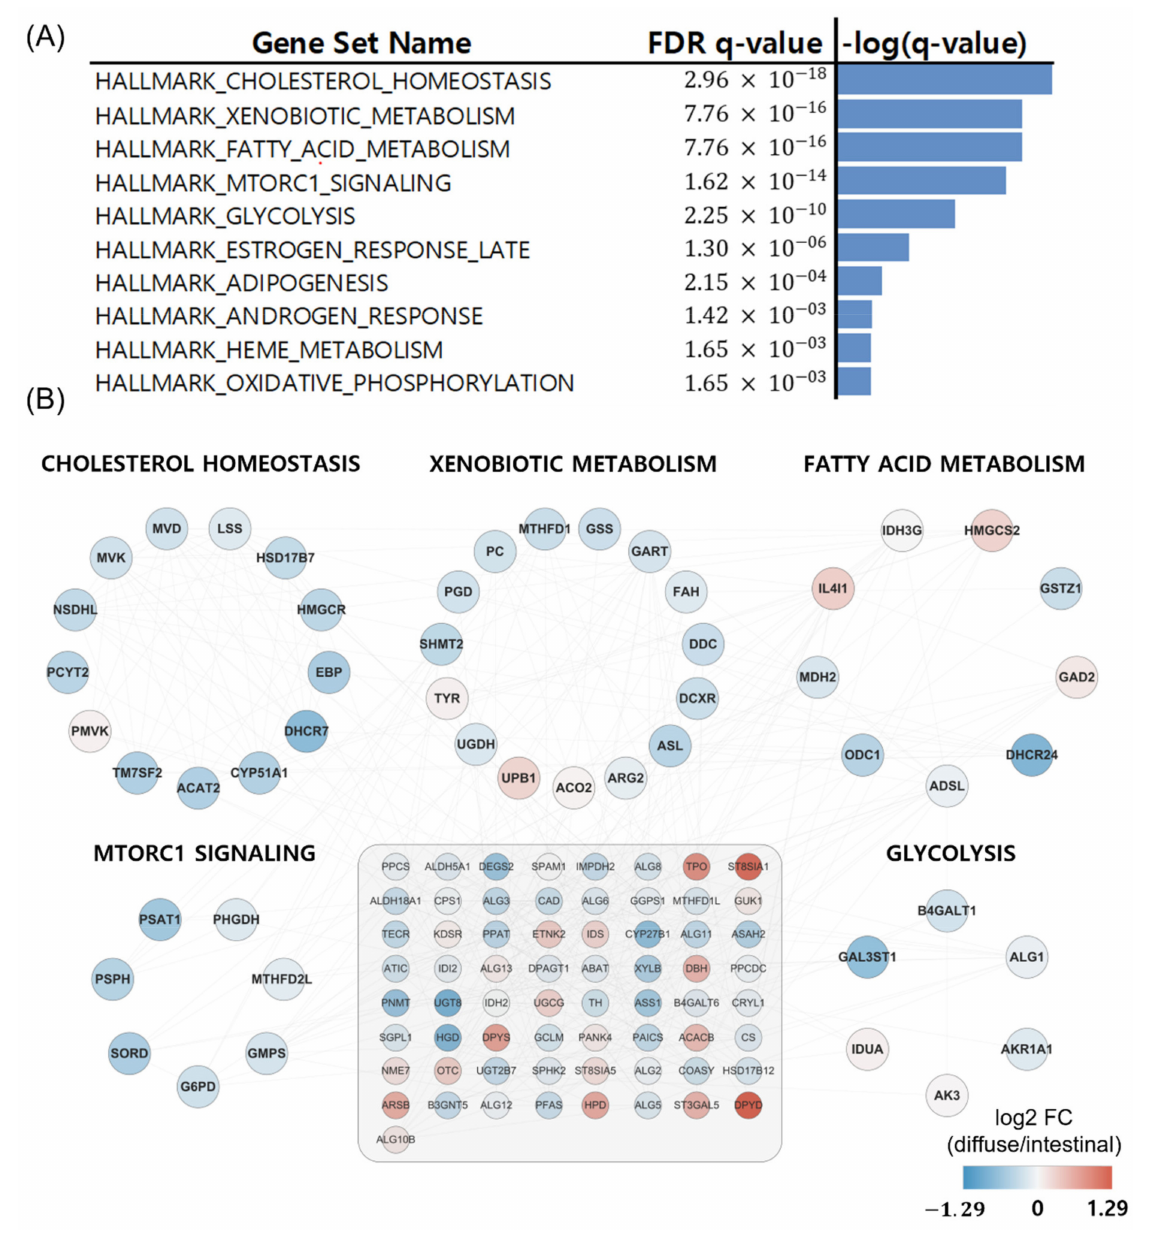
Figure 5. Metabolizer revealed differential metabolic subpathways in diffuse versus intestinal types in the TCGA. ( A ) Top ten significant pathways in diffuse versus intestinal subtypes. ( B ) Genes involved in the top five differential metabolic pathways. The 65 genes in the grey-shaded rectangle indicate the genes sharing the five differential metabolic